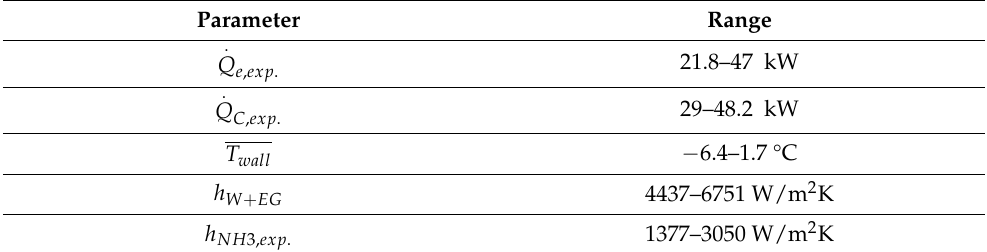
Table 4. Variation intervals for calculated data.